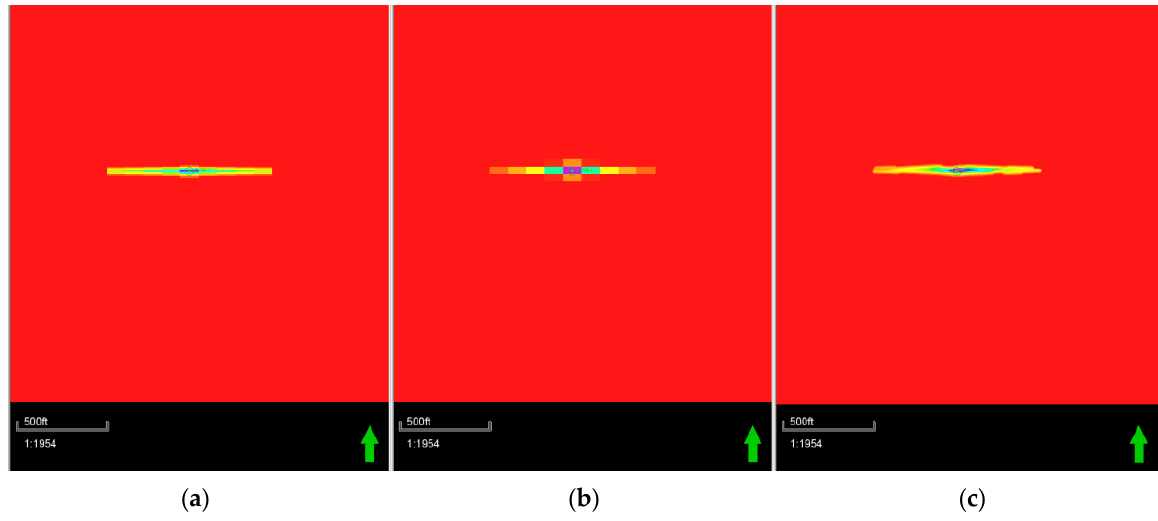
Figure 6. Pressure map in early time for ( a ) Base Case, ( b ) Coarse Case, and ( c ) Reference.